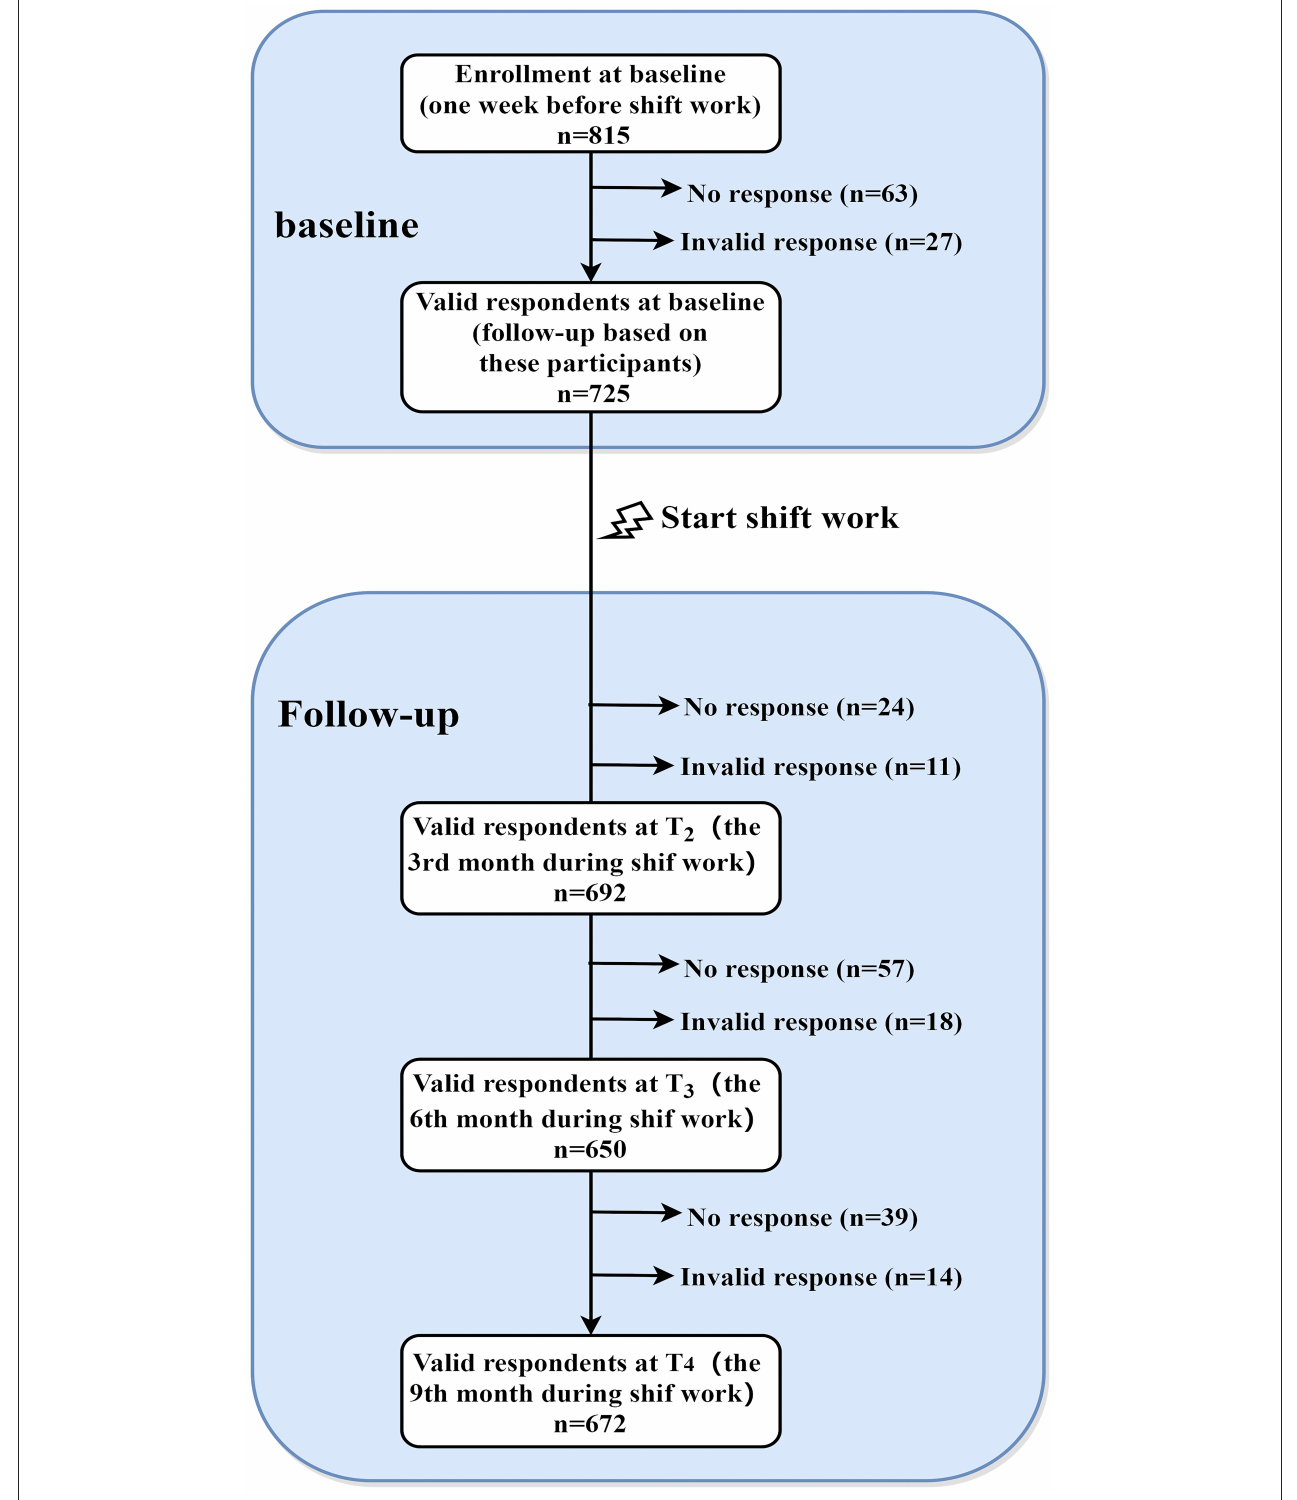
FIGURE 1 | Sampling procedure for the current